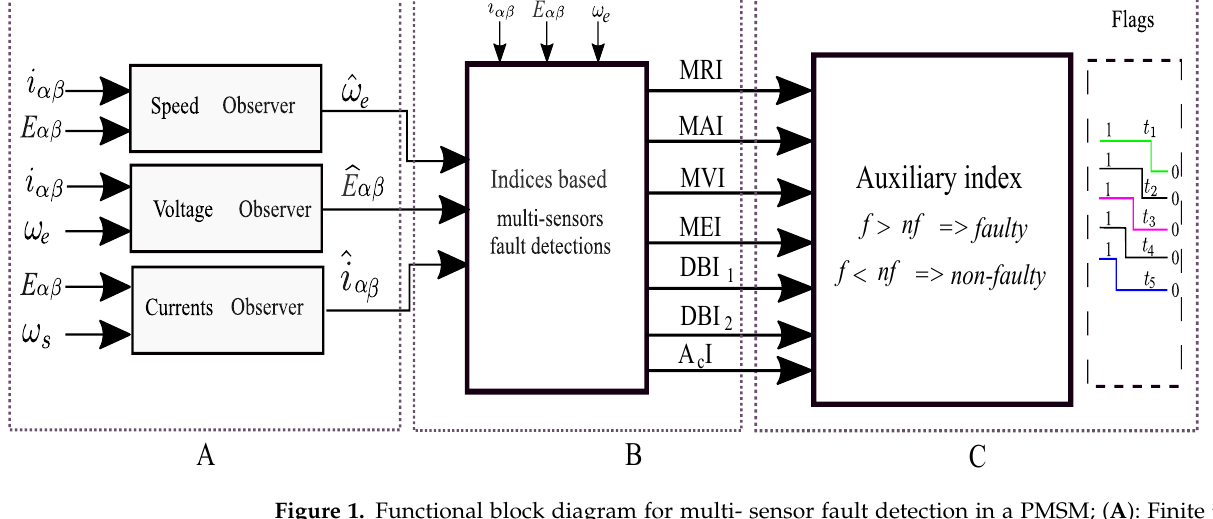
Figure 1. Functional block diagram for multi- sensor fault detection in a PMSM; ( A ): Finite time observer block; ( B ): Indices based detections using the residuals; ( C ): Fault Identification with the